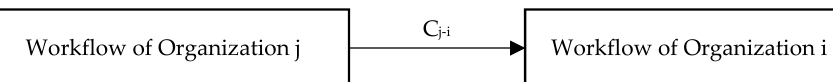
Figure 3. The Binary Design Structure Matrix used to determine the correlations between the workflows of different organizations.